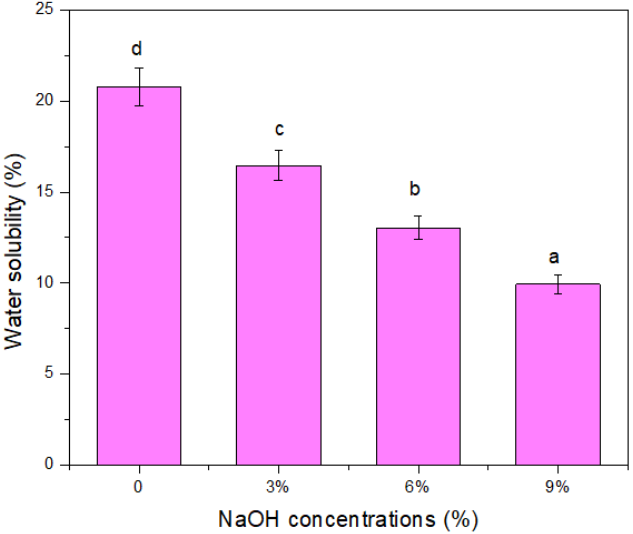
Figure 13. Water solubility of untreated and treated TPCS/PW/CCF composites. Letters a, b, c and d is indicates the group of data for statistical analysis.